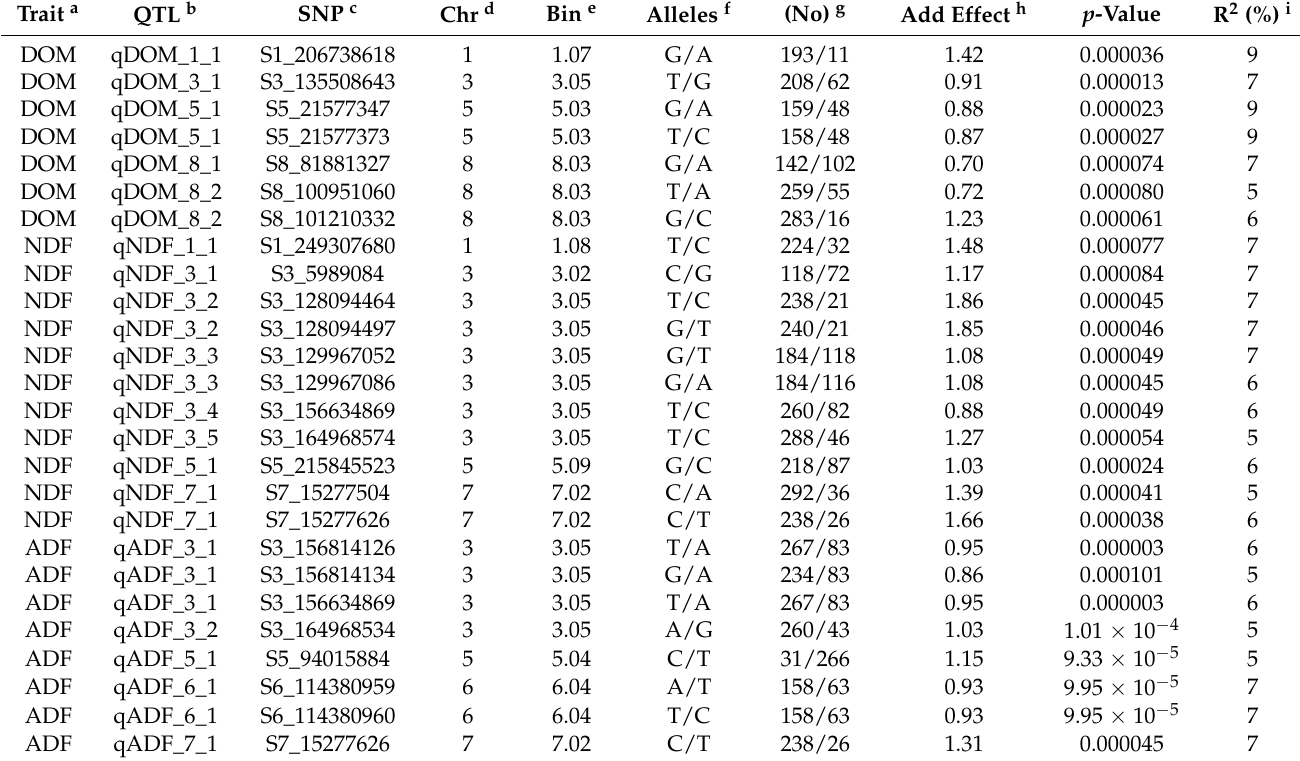
Table 4. SNPs and QTL significantly associated for final use of maize stover traits Digestibility of the organic matter and fibers), including SNP’s chromosome, bin and position within chromosome, allelic variants, number of lines with an allelic variant, and additive effect for the SNP, proportion of total variance explained by the SNPs and p -value for the association between the SNP and the